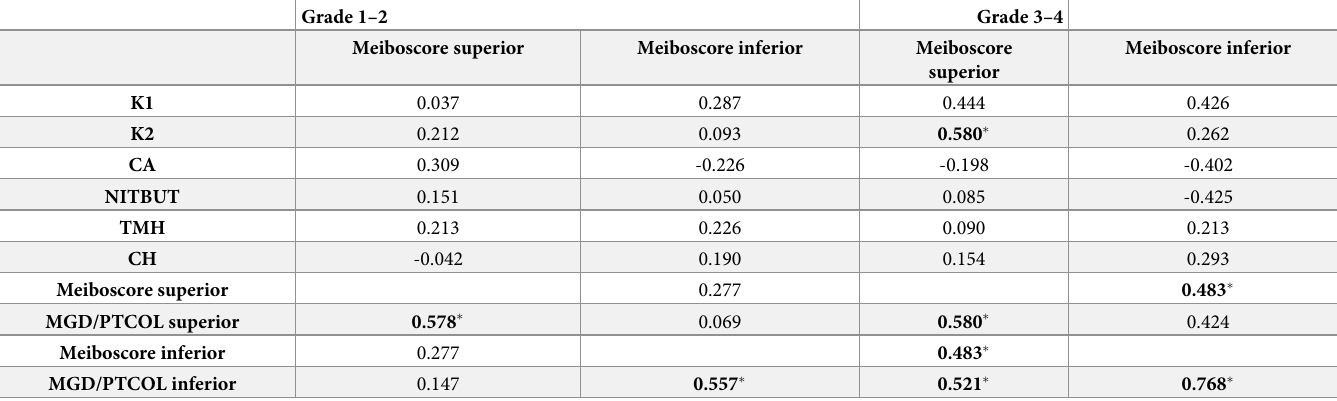
Table 4. Correlations between meibomian gland dysfunction and ocular surface parameters according to pterygium grades